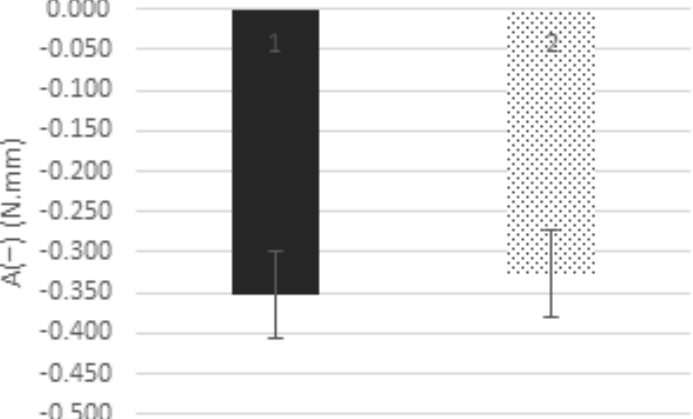
Figure 4. Texture analysis of the facial masks. ( 1 ) mask containing 5% of SSP; ( 2 ) control. Adhesiveness (A( − )) is represented in the bars as mean ± standard deviation. No significant differences were found between samples ( p > 0.05).